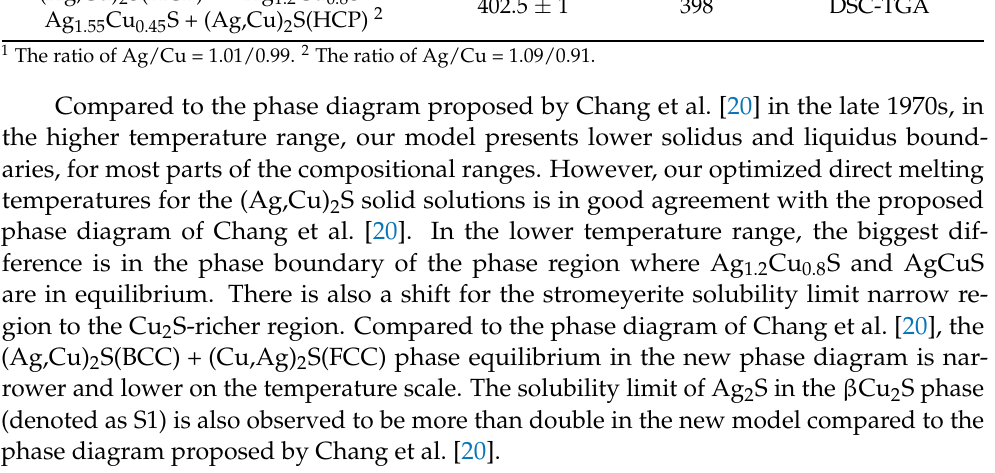
Table 4. Comparison of the optimized and our experimentally determined thermodynamic properties. Exp. and opt. represent experimental and optimized, respectively. Temperature (K) Exp. Method Reaction Exp. Opt. AgCuS (cid:29) (Ag,Cu) 2 S(HCP) 1 375 ± 1 387 EMF (Ag,Cu) 2 S(FCC) 2 (cid:29) L 922.3 ± 1 930 DSC-TGA (Ag,Cu) 2 S(HCP) 2 + Ag 1.2 Cu 0.8 S (cid:29) Ag 1.55 Cu 0.45 S + (Ag,Cu) 2 S(HCP)